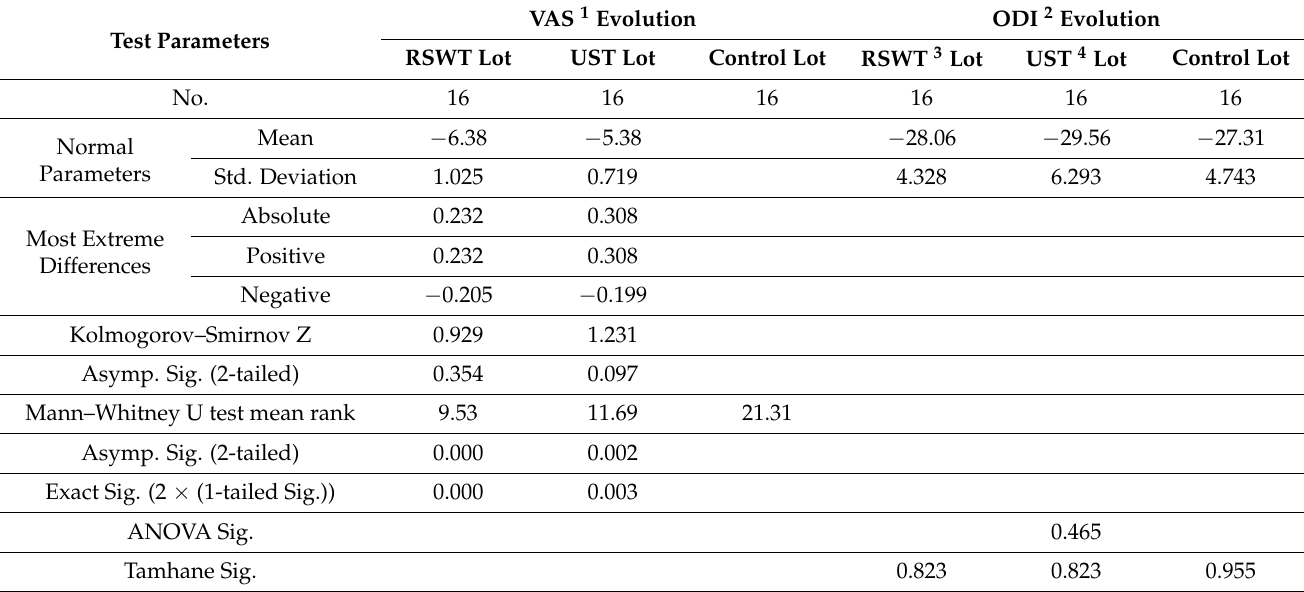
Table 3. Pain and disability index reported using the VAS and ODI